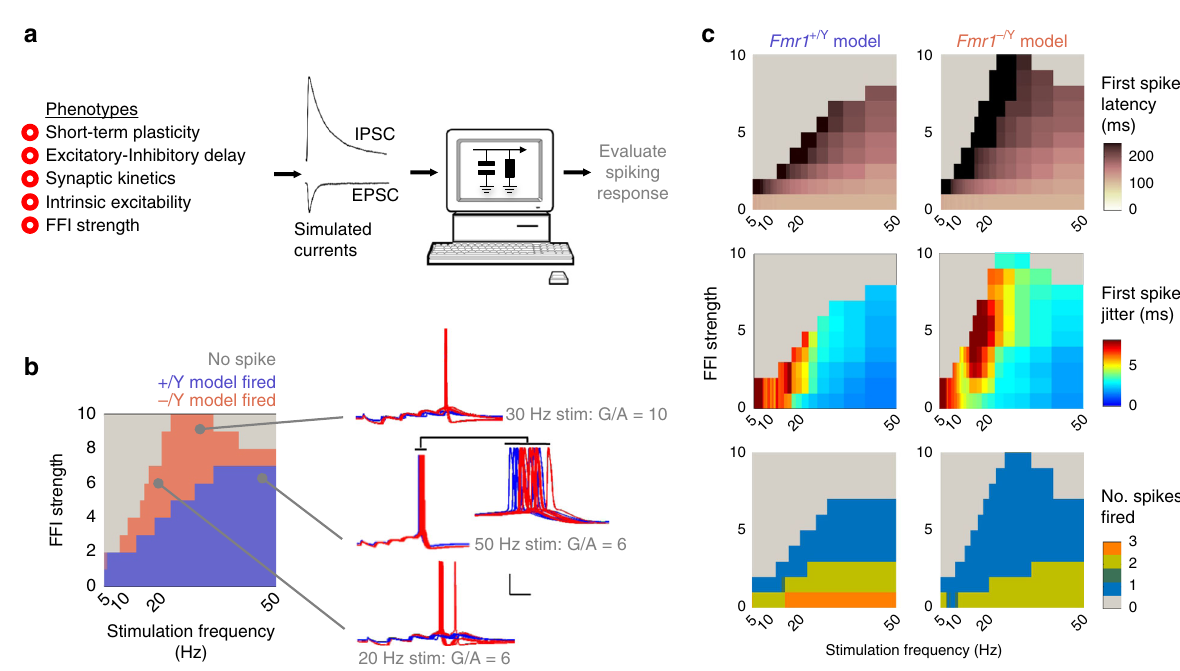
Fig. 7 Modelling TC summation recapitulates spiking phenotypes of Fmr1-KO layer 4 SCs. a Schematic of modelling approach. Left: Five grouped covariates measured from Fmr1 + /Y and Fmr1 − /Y recordings used in simulation. Centre: Simulated synaptic inputs were tuned with kinetics of recorded currents. Right: Parameter spaces were explored in silico to fi nd conditions that either enhanced or suppressed fi ring in the Fmr1-KO model compared with the WT model. b Left: Input frequency dependence of simulated spiking responses for model Layer 4 neurons receiving different strengths of FFI (G/A ratios between 0 and 10 tested). Coloured areas for each modelled genotype indicate combinations of FFI strength/stimulation frequency at which the models fi red at least one spike per trial. Red indicates fi ring parameter ranges in addition to those of the WT model. Note: (1) moderate strength FFI in the WT model prevents spike fi ring even at high input frequencies (2) the increased number of simulation conditions leading to spiking in the Fmr1 − /Y model, (3) the insensitivity of spiking regulation in the Fmr1 − /Y model to inhibitory tone even with FFI strengths elevated to extreme levels (10 trials overlaid). Right: example traces for simulated spiking by the two models at different parameter combinations. Inset: note later and more variable spike times in the Fmr1 − /Y model. Scale: 20 mV/50 ms. c In addition to affecting the overall spike fi ring response shown in ( b ), genotype-dependent effects were observed in the latency, timing variability and count of spikes fi red. Spikes fi red later and with lower temporally precision in the Fmr1 − /Y model across a broad range of model conditions, even with the FFI strength increased to the extreme values as observed in the Fmr1 − /Y recordings. More conditions led to spiking in the Fmr1 − /Y , despite a slight decrease in numbers of spikes fi red per trial across the distribution compared with Fmr1 + /Y